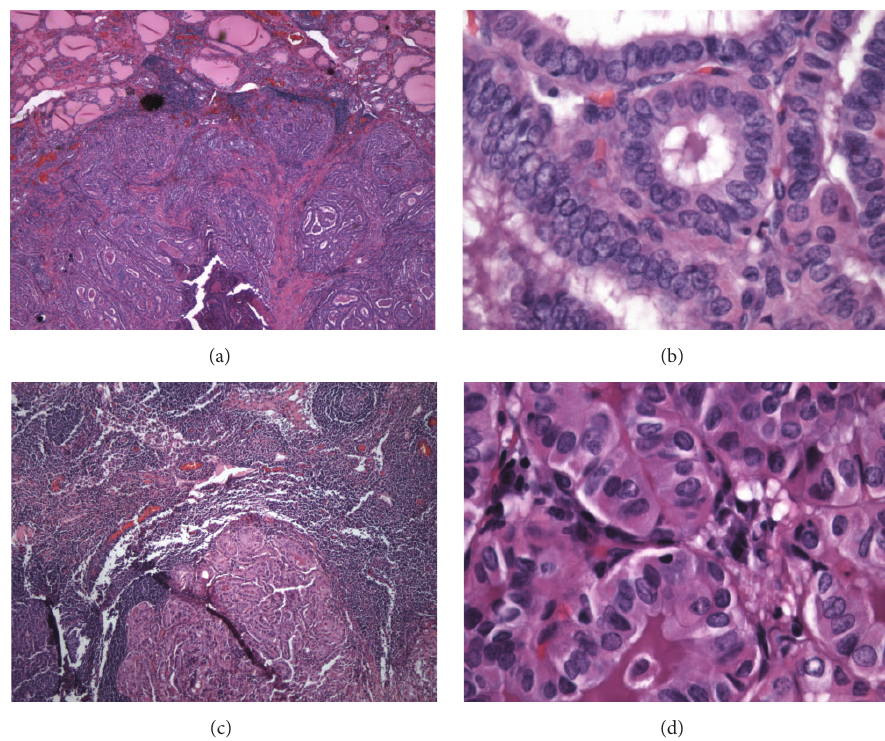
Figure 3: Papillary thyroid cancer microscopic examination. (a) Papillary thyroid carcinoma. Circumscribed nodule with papillary and follicular architecture and background fibrous bands (H&E, 2x). (b) Nuclear crowding, oval to elongated nuclei with fine open chromatin, nuclear membrane irregularity, and nuclear grooves (H&E, 40x). (c) Lymph node showing metastatic papillary thyroid cancer (H&E, 4x). (d) Metastatic papillary thyroid cancer nuclear features (nuclear crowding, fine open chromatin pattern, nuclear grooves, and nuclear membrane irregularity) (H&E,